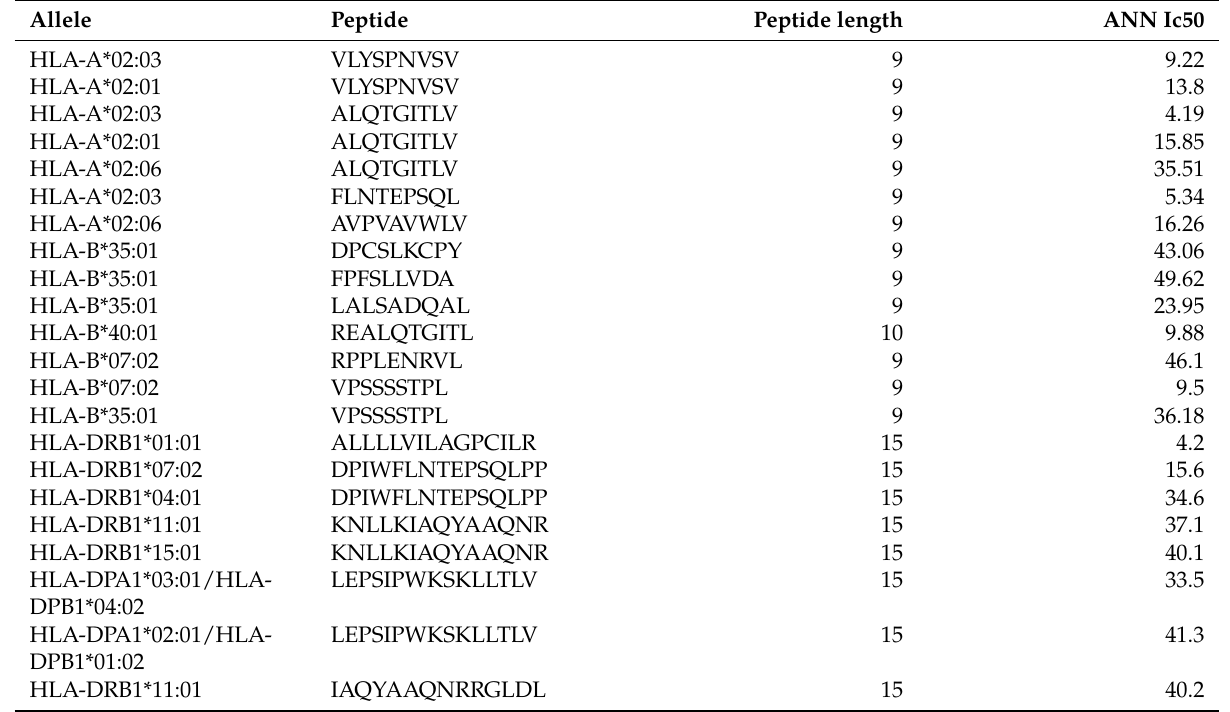
Table 2: Selected epitopes for MHCI and MHCII based on ANN IC50